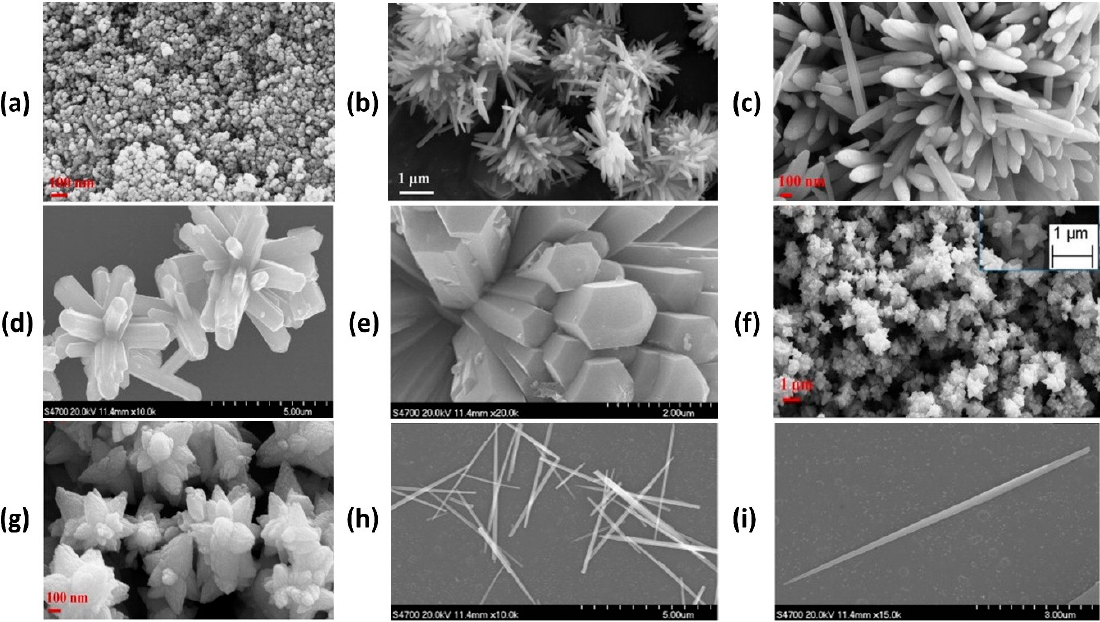
Figure 11. Illustration of different morphologies of nZnO taken by FESEM analysis: ( a ) ZnO nanoparticles; ( b – e ) ZnO nanorods; ( f , g ) ZnO nanoflowers; and ( h , i ) ZnO nanoneedles. Reprinted with permission from References [89,90]. Copyright 2010, 2013 respectively, with permission from Elsevier.